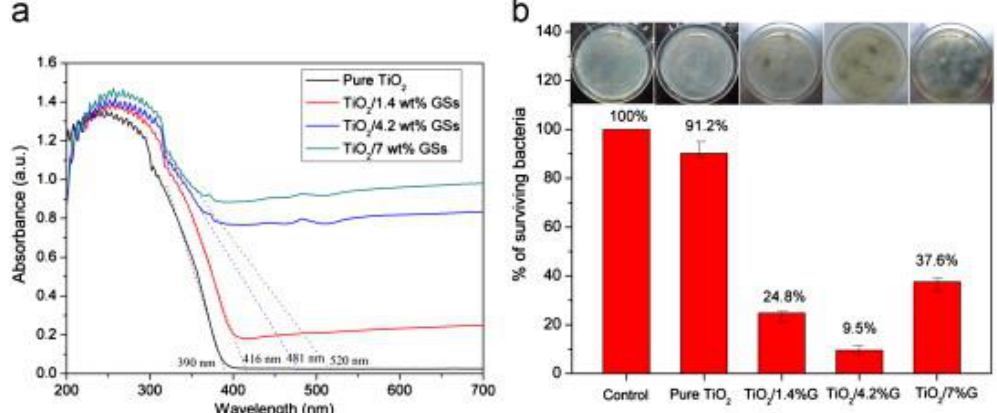
Figure 10. ( a ) UV-Vis absorption spectra of pure TiO 2 nanoparticles, TiO 2 / GSs with TiO 2 / 1.4 wt%, TiO 2 / GSs with TiO 2 / 4.2 wt% and TiO 2 / GSs with TiO 2 / 7 wt%. ( b ) Viabilities of E. coli incubated with various TiO 2 -based nanocomposites under visible light illumination for 12 h. The insets are the corresponding photographs of agar plates. Reproduced with permission from ref. [88]. Copyright © 2013, Elsevier.